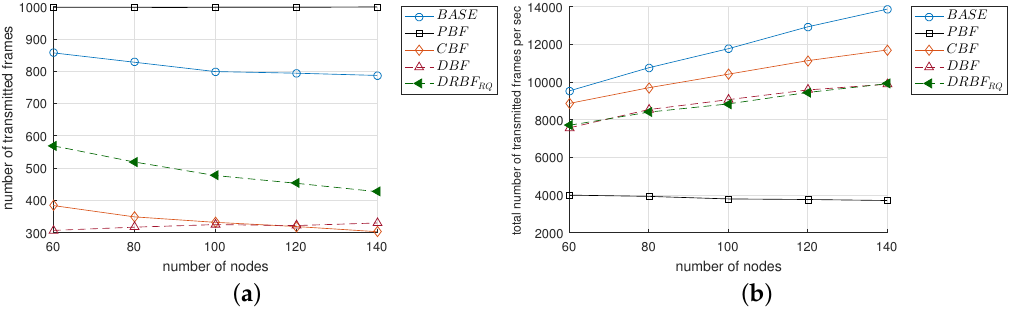
Figure 12. The performance comparison of the flooding mechanisms in terms of ( a ) the number of transmitted frames F tx and ( b ) the total number of transmitted frames per second R tx